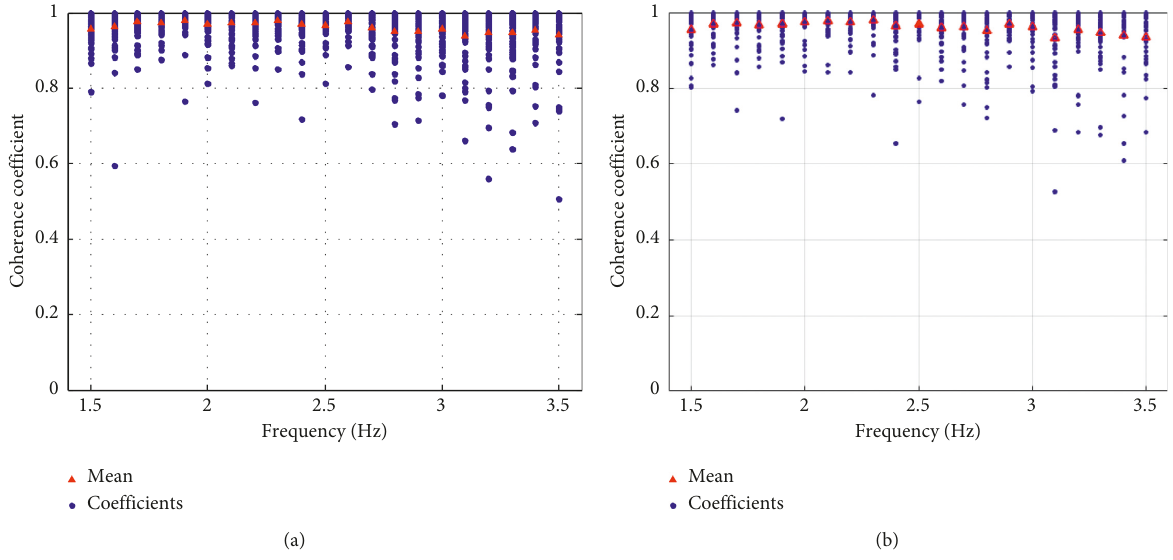
Figure 18: Coherence coefficients of all cases along with frequency at two lateral distances of (a) 1m and (b) 2m.